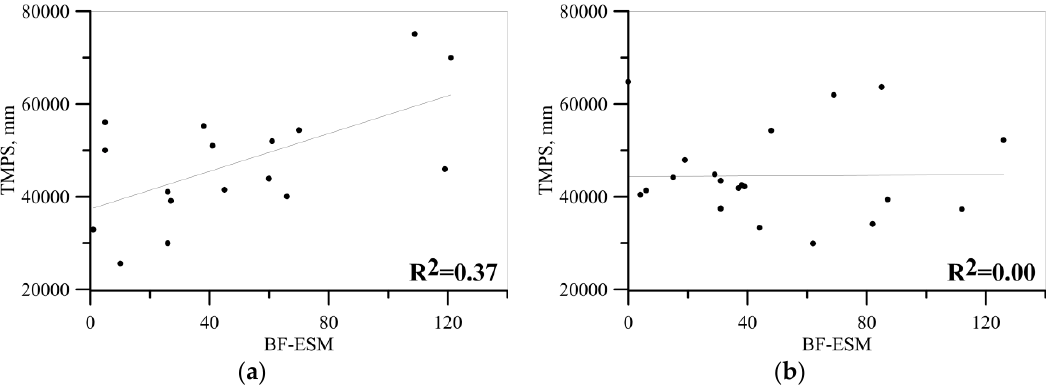
Figure 5. Scatterplots of the ESM-BF and TMPS for 1979–1995 ( a ), and 1996–2010 ( b ). The black line denotes linear regression between the two quantities found by the least-squares fit, and R 2 is shown at the bottom right.